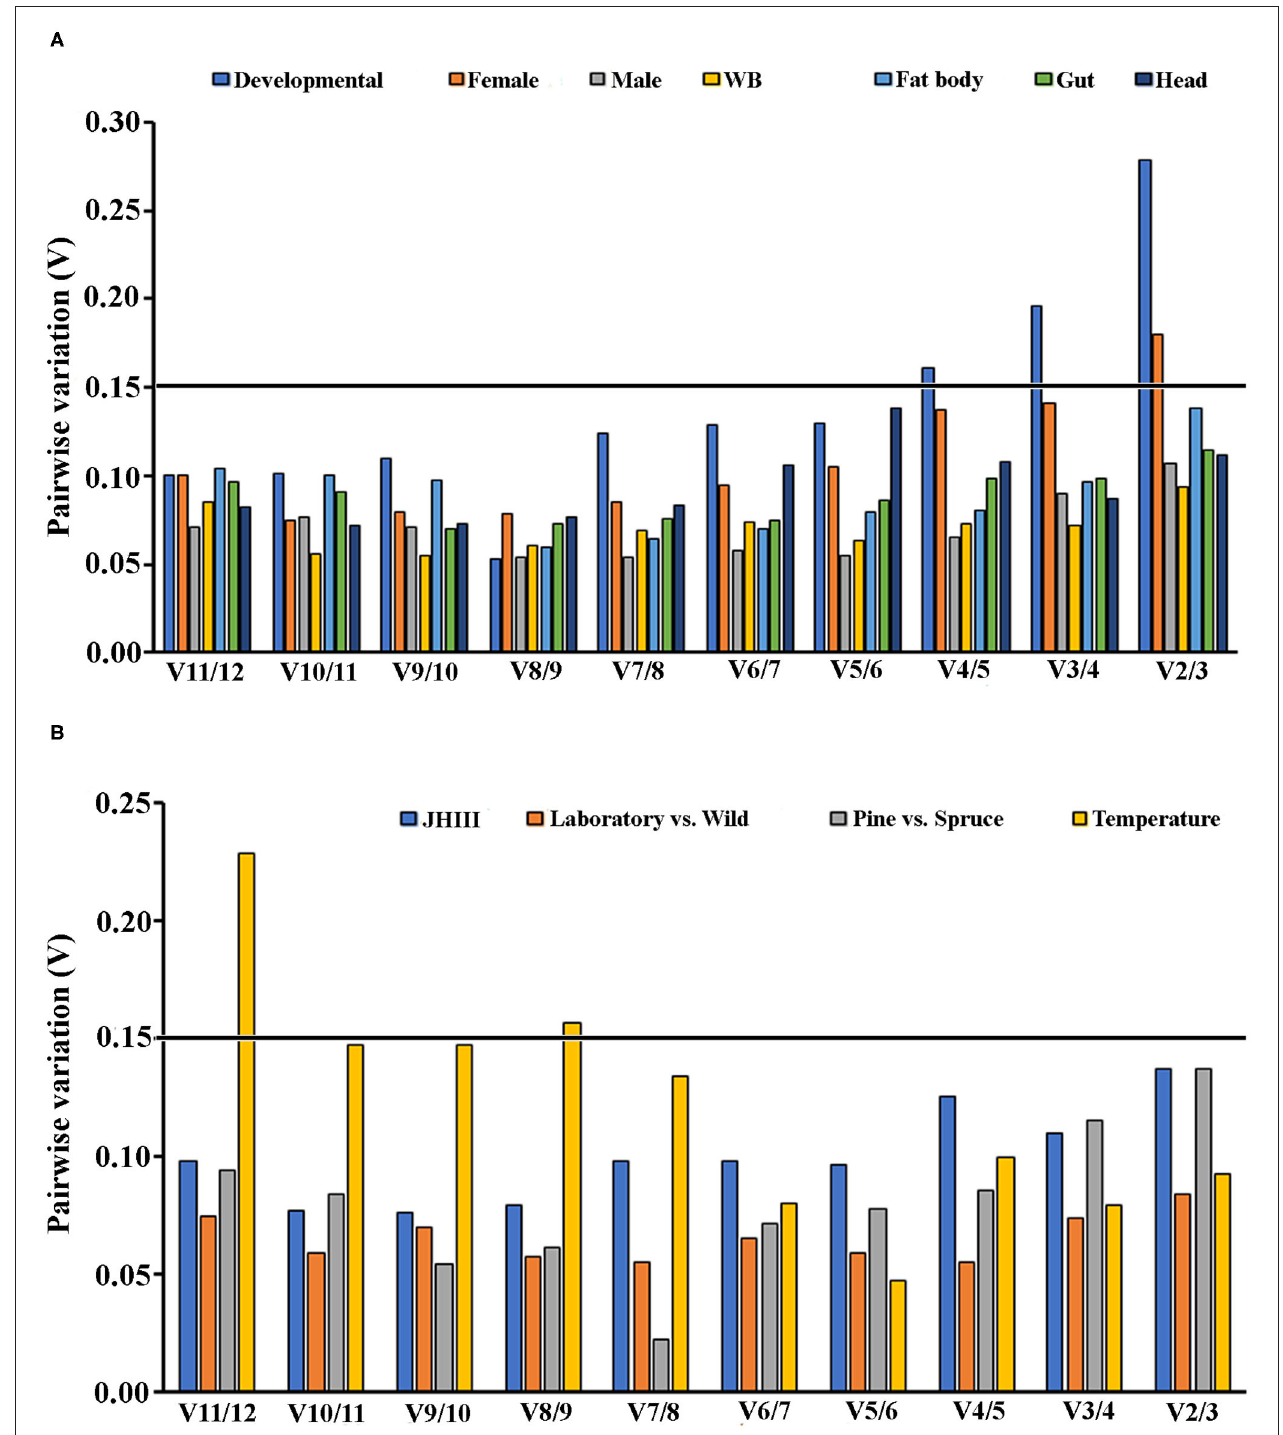
FIGURE 4 | An optimal number of reference genes for the normalization of ISx under selected extrinsic experimental conditions. Based on geNorm analysis, average pairwise variations were calculated between the normalization factors NFn and NFn + 1. Values < 0.15 indicate that n + 1 genes were not required for the normalization of gene expression. (A) Biotic conditions: developmental stages (i.e., larvae, pupae, and adult stages), tissue types [head, midgut, fat body, and whole body (WB) except head, gut, fat body] and (B) Abiotic conditions: different treatments (temperature; Juvenile hormone III; wild-collected vs. long-term laboratory-reared; and different host feeding). Values < 0.15 indicate that additional genes are not necessary for normalization.